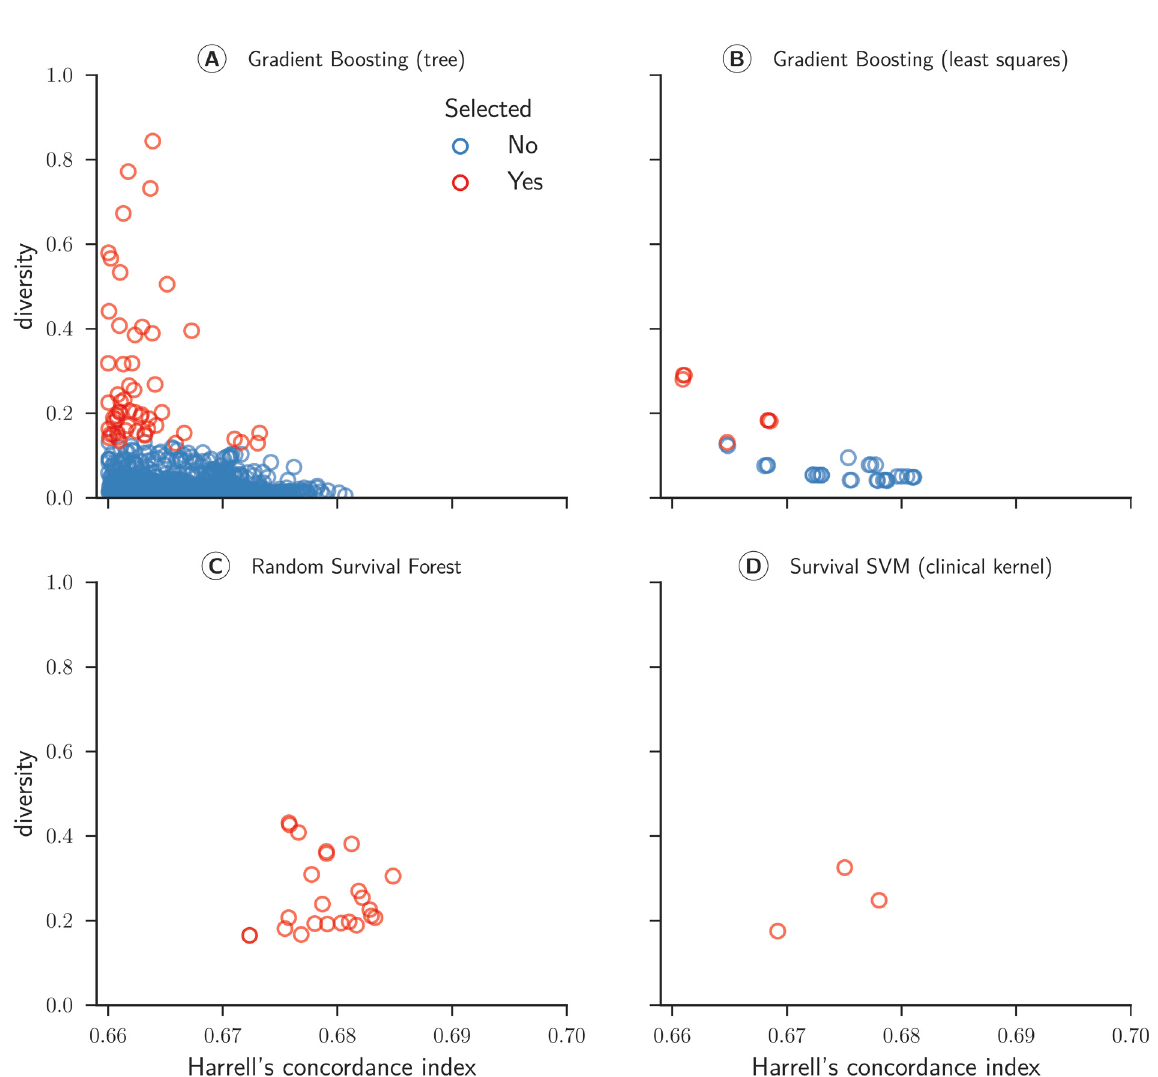
Figure 6. Concordance index and diversity score of 999 survival models for sub challenge 1a. The concordance index was evaluated by cross-validated models on the training data from the from the ASCENT-2, VENICE, and MAINSAIL trial. Diversity was computed based on Pearson’s correlation coefficient between predicted risk scores for 313 patients of the ENTHUSE-33 trial (final scoring